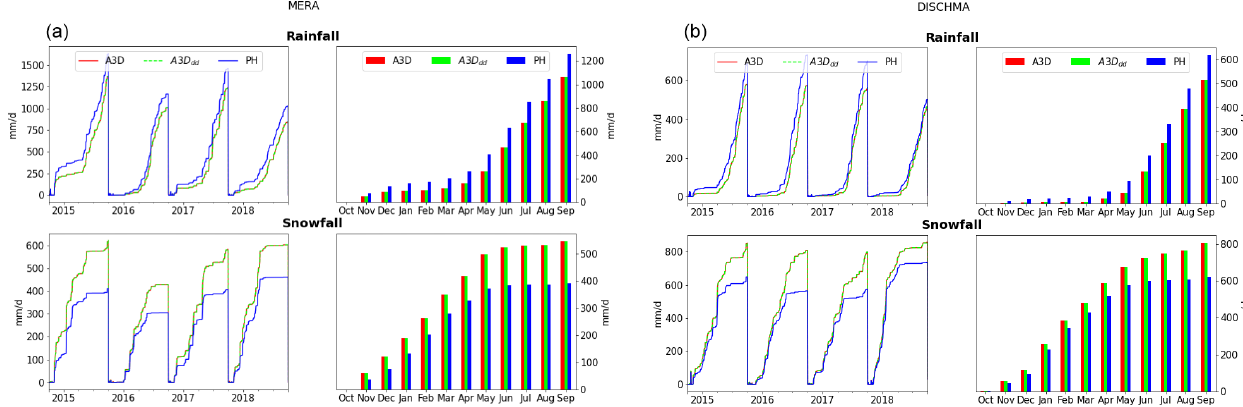
Figure 2. Comparison of solid and liquid precipitation in A3D/A3D DD and PH for the Mera (a) and Dischma (b) catchments.